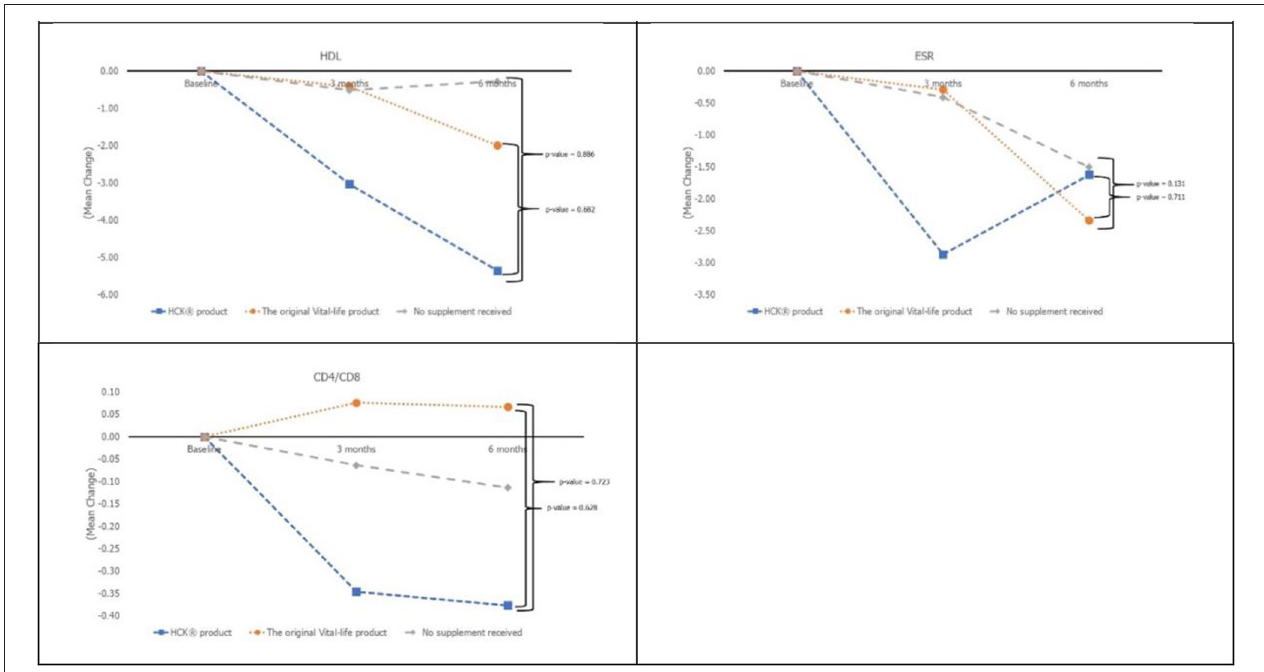
FIGURE 3 | Secondary laboratory outcomes at baseline, month 3 and 6 among all 3